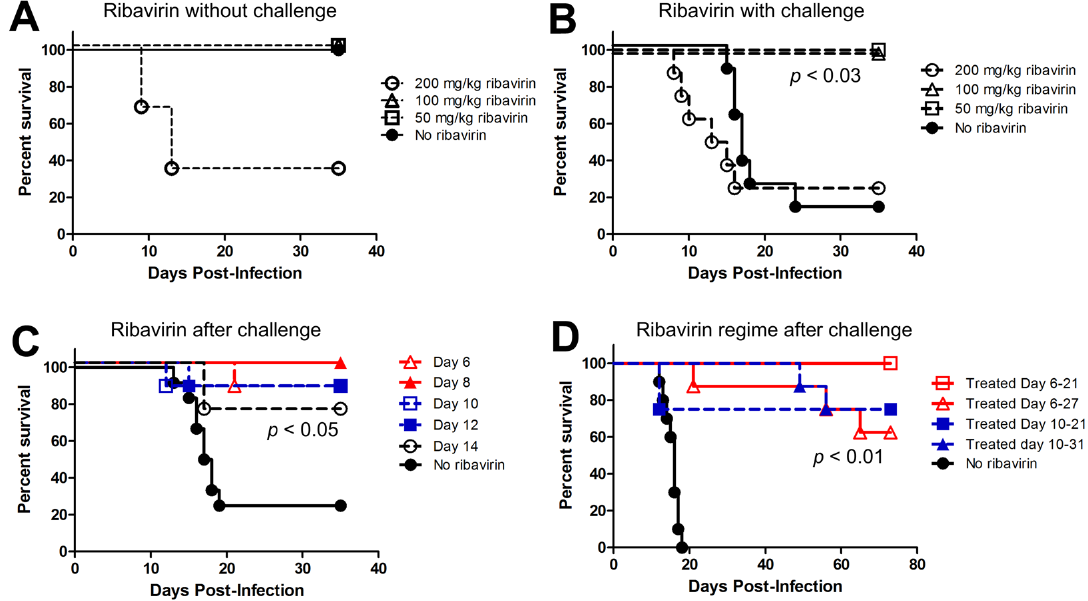
Figure 3. Survival curve of hamsters with mock or ribavirin-treatment following infection with ANDV. ( A ) To test drug toxicity, hamsters were given either 50, 100, or 200 mg/kg/day of ribavirin, or mock treated (no ribavirin), for 21 days and then observed thru 35 days post-infection; ( B ) Hamsters were challenged with 4,000 pfu by the i.n. route and, starting on day 0, given either 50, 100, or 200 mg/kg/day of ribavirin, or mock treated, for 21 days. Animals were observed for signs of disease for 35 days after challenge. Treatment with ribavirin protected animals after infection with ANDV at 100 mg/kg and 50 mg/kg doses ( p = 0.02 and 0.03, respectively). There was no difference between animals given 200 mg/kg after infection and animals infected without treatment, which confirms the above findings that ribavirin is lethal at a dose of 200 mg/kg; ( C ) Survival curve of hamsters mock or treated with 50 mg/kg/day ribavirin starting at days 6, 8, 10, 12, or 14 following infection with ANDV. All treatment groups had significantly higher survival compared to untreated ( p < 0.05); ( D ) Animals receiving treatment began at either at day 6 or 10 post-infection survived infection with ANDV for 11, 15 or 21 days. All treatment groups had significantly higher survival compared to untreated ( p < 0.01) Survival analyses were performed by computing pair-wise comparisons to controls using the nonparametric Mantel-Cox test and the resulting p -values were adjusted using the Holm-Bonferroni method for multiple